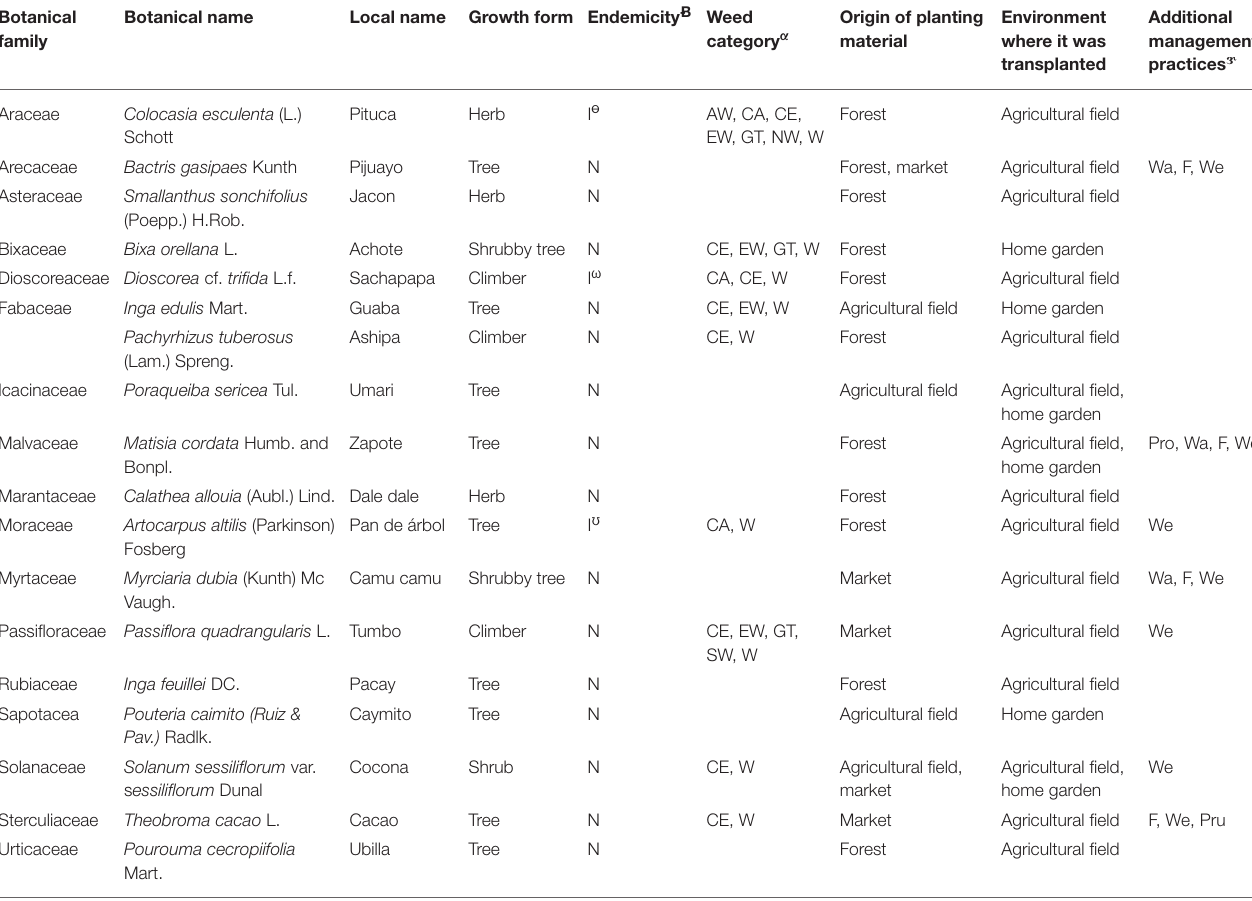
TABLE 1 | List of transplanted “wild” food plant species indicating botanical name, local name, growth form, endemicity, weed category, origin of planting material, environment where the species was transplanted, and additional management practices ( n =